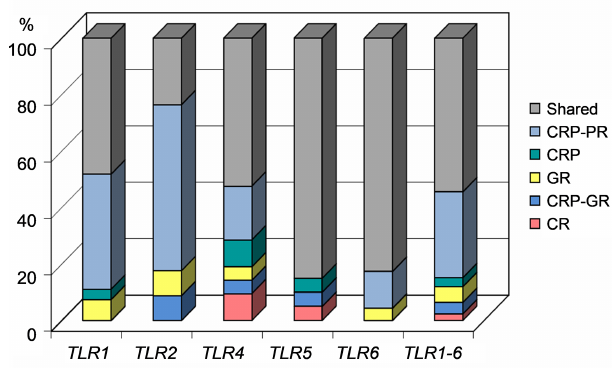
Figure 1. Proportion of gene variants according to the assignment to the studied cattle populations. CRP – Czech Red Pied cattle, CRP-PR – production population of CRP, GR – conserved popu- lations in genetic resources, CRP-GR – conserved subpopulation of CRP, and CR – conserved Czech Red